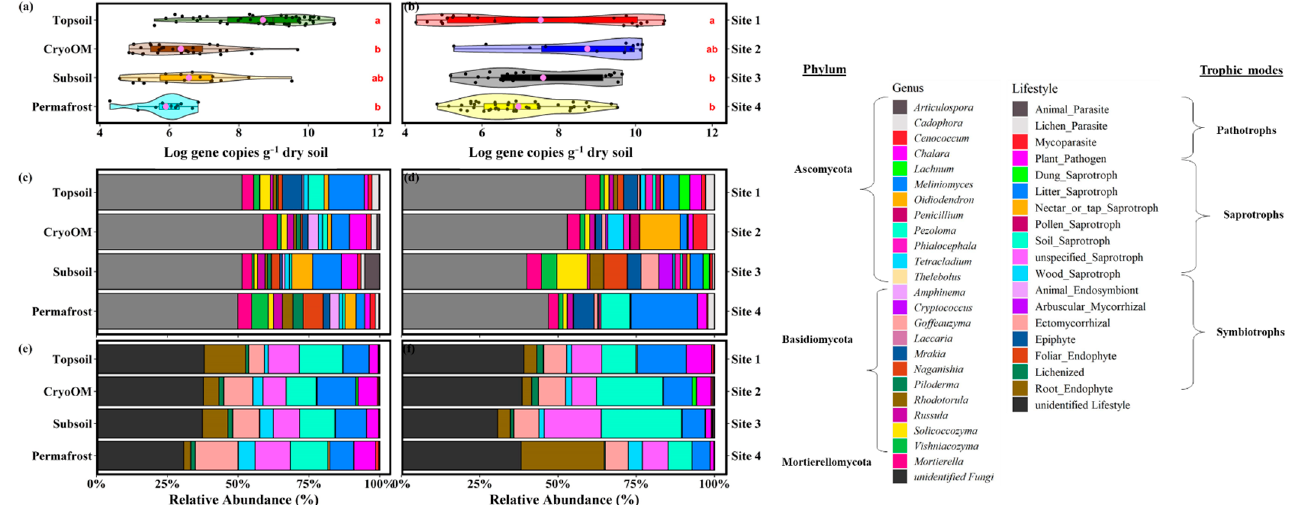
Figure 1. Fungi gene abundance and community composition. Log-transformed fungal gene copies per gram dry weight of soil are shown for ( a ) horizon and ( b ) tundra site. Based on Tukey’s HSD post hoc tests, gene abundance that differed between horizons and tundra sites was represented by different letters. The lavender point inside the bar plot suggested a mean value. The relative fungal taxonomic composition at genus level and fungal lifestyle for ( c , e ) horizon and ( d , f ) tundra sites were shown, respectively. Only those genera which had >1% relative proportion and filled to 100% were shown, whereas all fungal lifestyles were depicted.